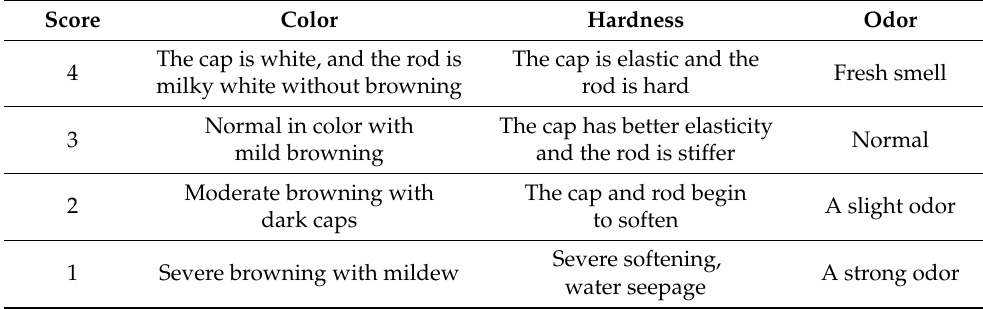
Table 1. Matsutake sensory indicator score